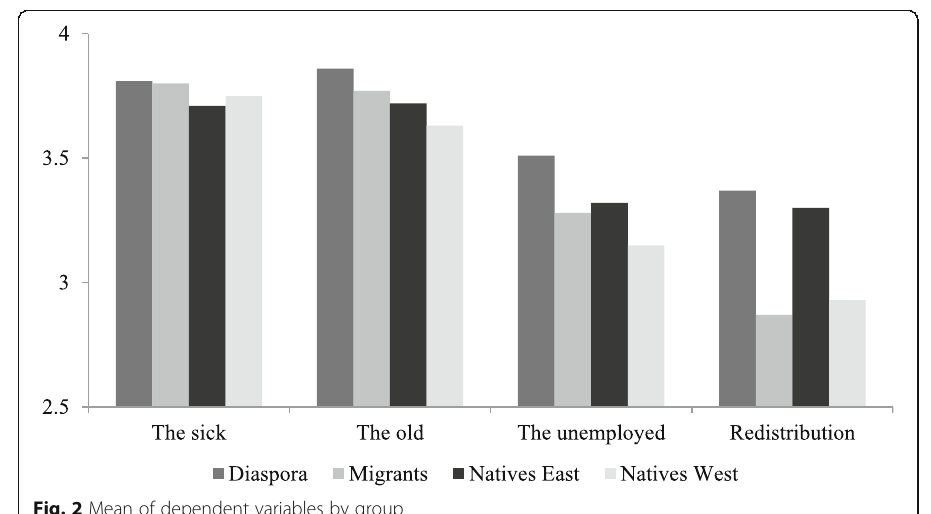
Fig. 2 Mean of dependent variables by